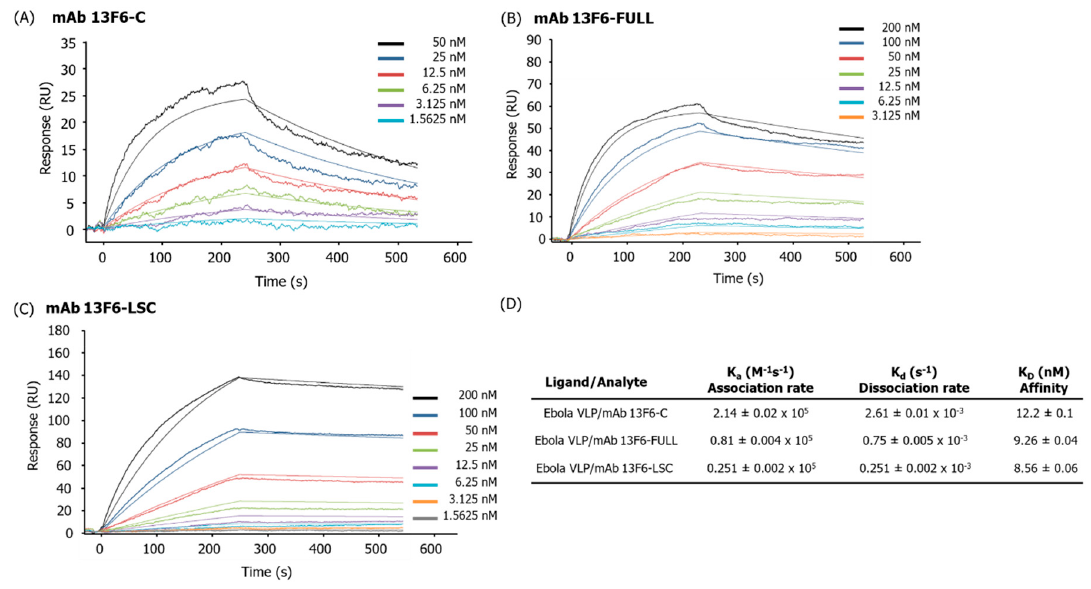
Figure 8. Surface plasmon resonance (SPR) analysis of the binding interactions of anti-Ebola virus (EBOV) mAb 13F6-C, mAb 13F6-FULL, and mAb 13F6-LSC to Ebola VLPs. ( A ) Two-fold serial dilution of the mAb 13F6-C (1.5625~50 nM) was injected onto the VLP surface. ( B ) Two-fold serial dilution of mAb 13F6-FULL (3.125~200 nM) was injected onto the VLP surface. ( C ) Two-fold serial dilution of mAb 13F6-LSC (1.5625~200 nM) was injected onto the VLP surface. SPR sensorgrams shown in thick lines were overlapped with the thin line and then fitted to a simple 1:1 interaction model curve. In each plot, the association and dissociation phases are seen. ( D ) The kinetic constant values are calculated using a simple 1:1 interaction model. The mAb 13F6-C, a commercial anti-EBOV antibody was injected as a positive control. VLP was fixed on an immobilized PEG sensor chip (approximately 1530 RU on the sensor chip).